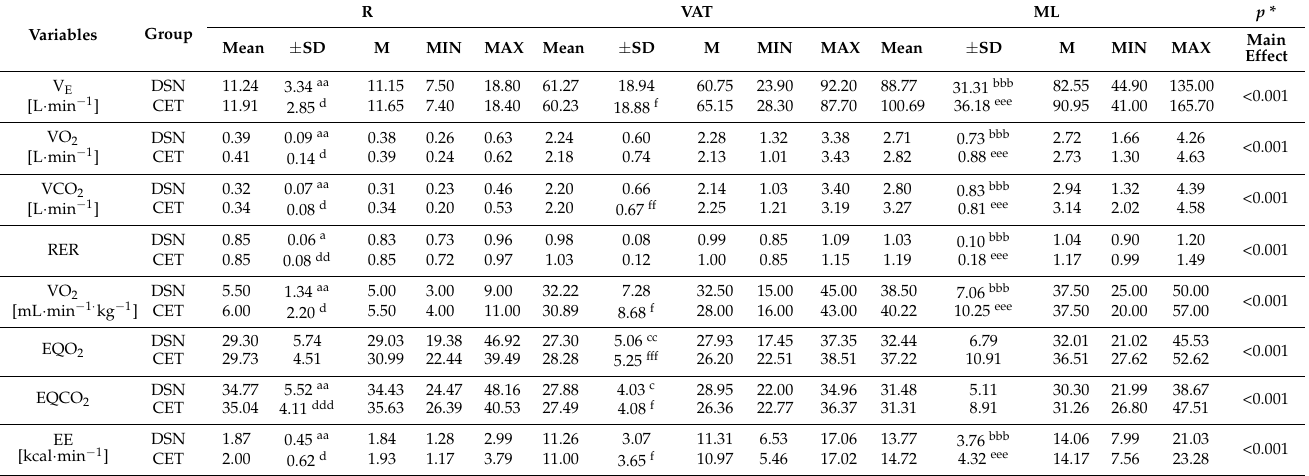
Table 2. Statistical comparisons of the respiratory and metabolic values obtained during DSN and CET (n = 18).